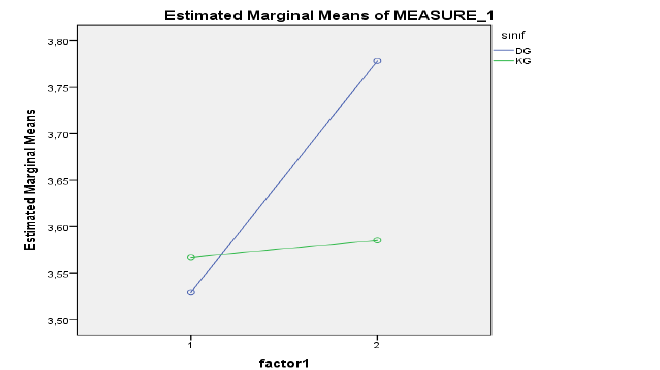
Figure 1 . The Effect of Creative Writing Activities on Forward Reading Awareness Level The pre-test and post-test scores that the experimental and control groups obtained from the scale are shown in Figure 1. Although pretest scores were close to each other and that there was no significant relationship between them, the posttest scores of the groups were found to be different as a result of the independent samples t-test. Posttest scores of the experimental group relatively increased compared to the control group. This increase may be interpreted as that creative writing activities are more effective in improving students' advanced reading awareness compared to the Turkish Language Teaching Program. However, this increase was not significant enough to reveal a statistical